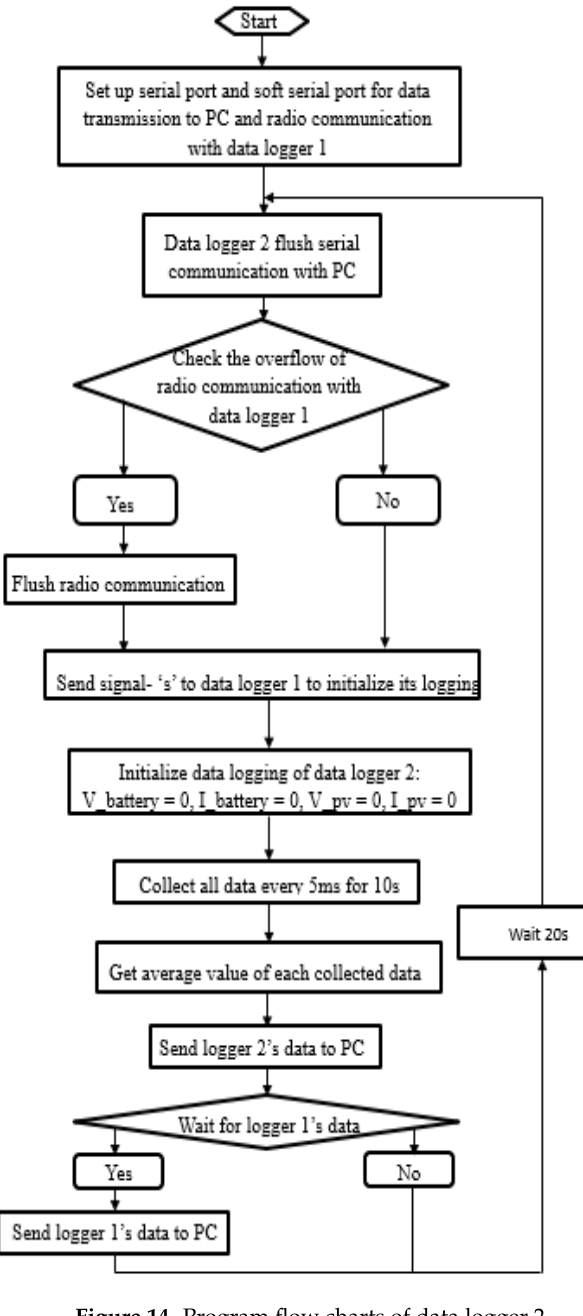
Figure 14. Program flow charts of data logger 2.